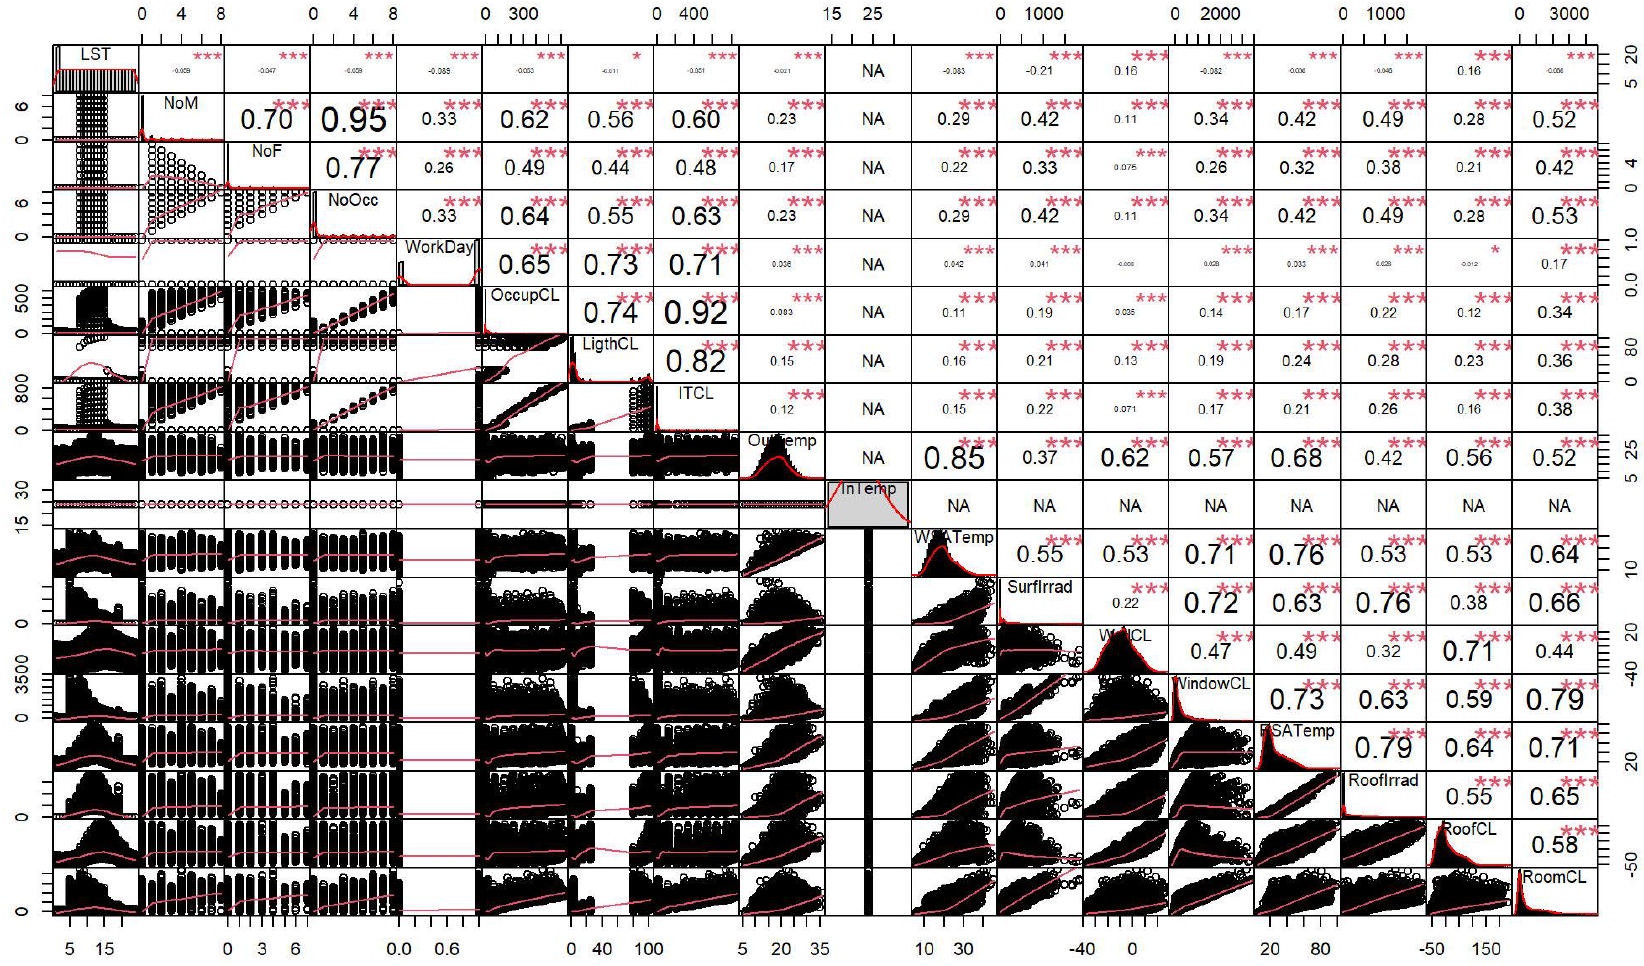
Figure 4. Pairwise correlation diagram for all-seasons dataset from 1 January 2015 to 31 December 2017.